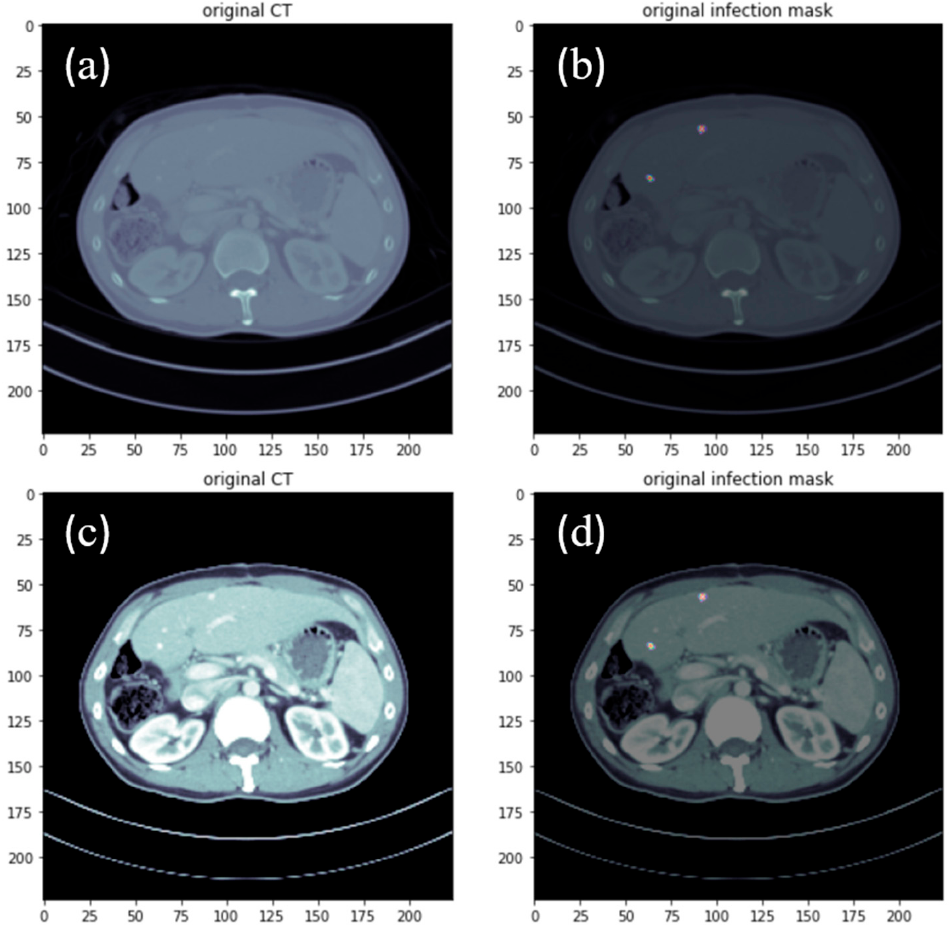
Figure 1. Before adjustment of HU values from the ( a ) original hospital CT image data and ( b ) annotated lesion image data (white colored is the location of the lesion); after adjustment of HU values from the ( c ) original hospital CT image data and ( d ) annotated lesion image data (white colored is the location of the lesion).